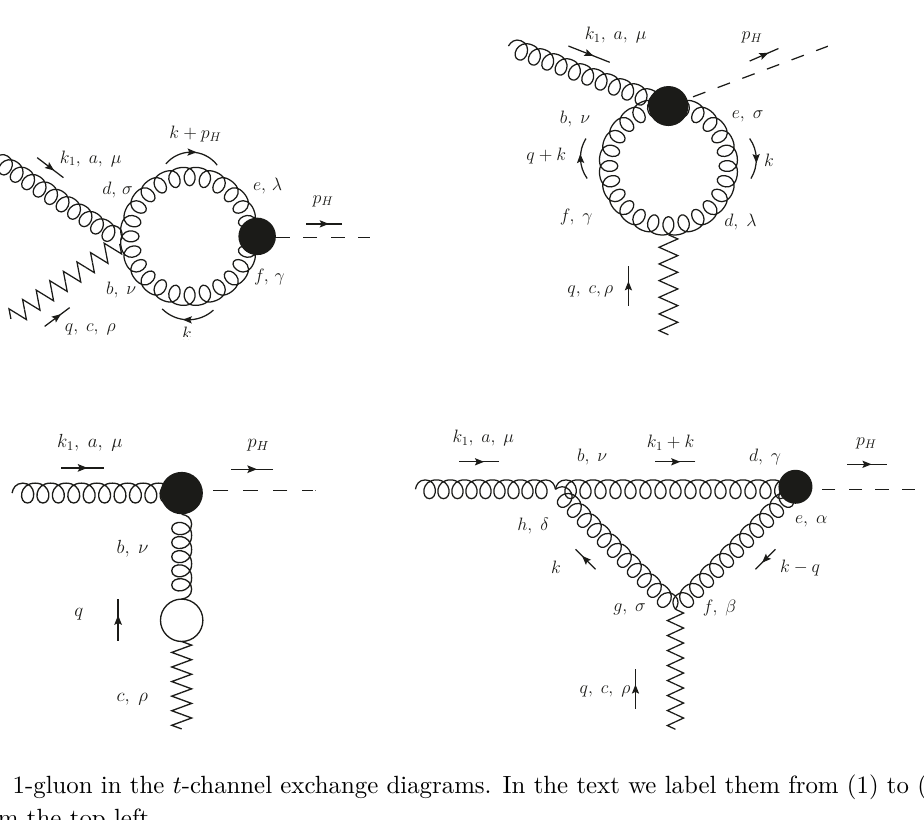
Figure 10 . 1-gluon in the t -channel exchange diagrams. In the text we label them from (1) to (4) starting from the top